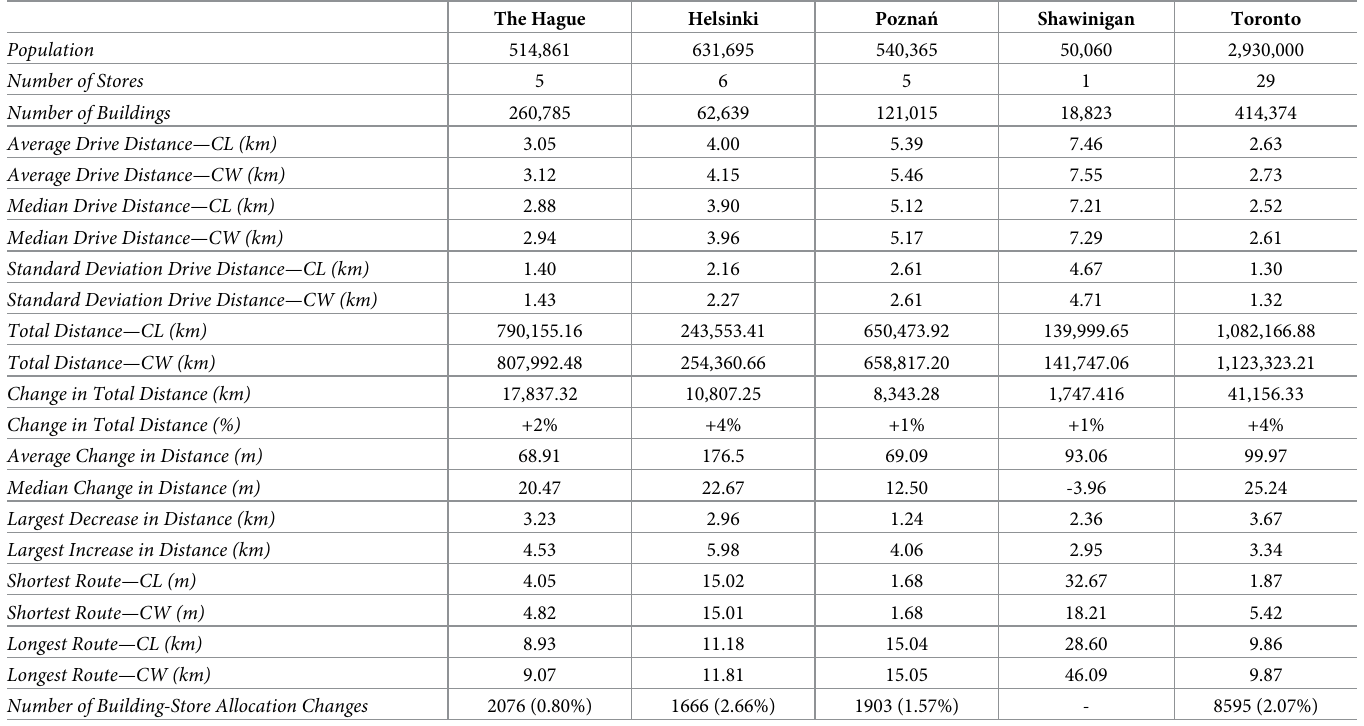
Table 5. Summary of the network analysis input parameters and results for centrelines and